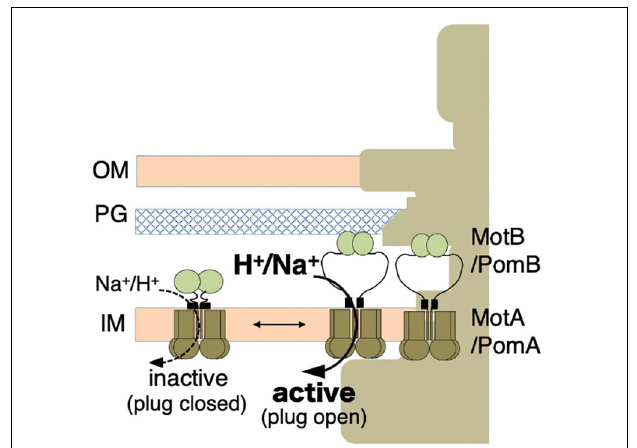
FIGURE 3 | Stator activation by the two-state model. The stator, composed of MotA or PomA and MotB or PomB, is activated by the coupling ions. The plug region is open in the active state. OM, outer membrane; IM, inner membrane; PG, peptidoglycan layer.